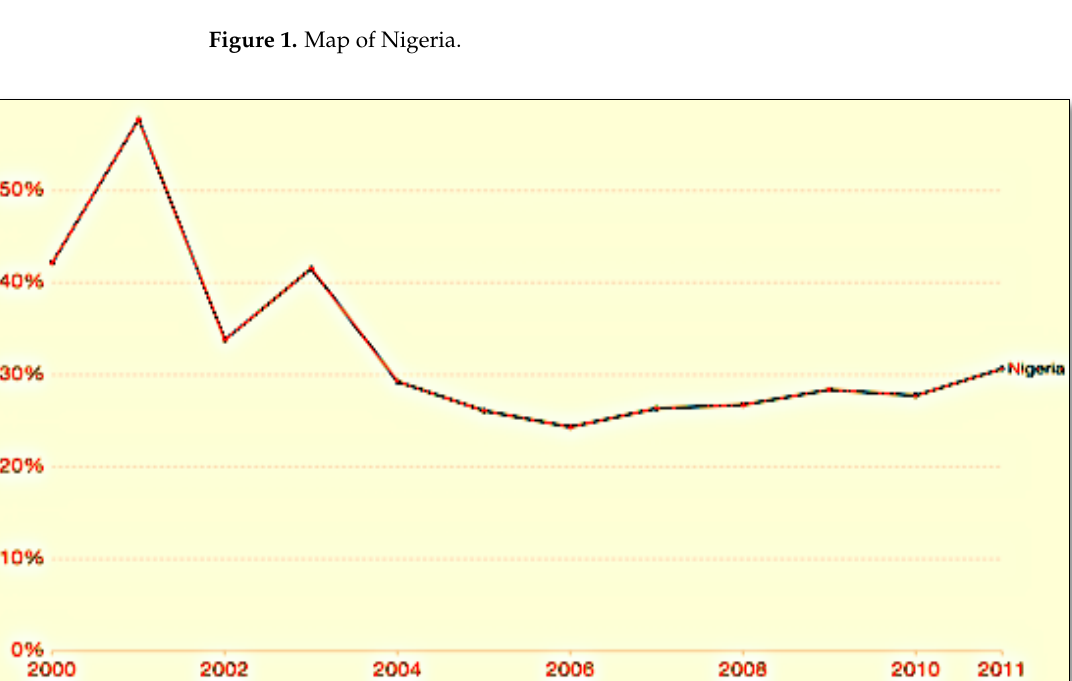
Figure 2. Nigeria’s Government Social Spending between 2000 and 2011 represented as a share of the GDP. Source: Author.